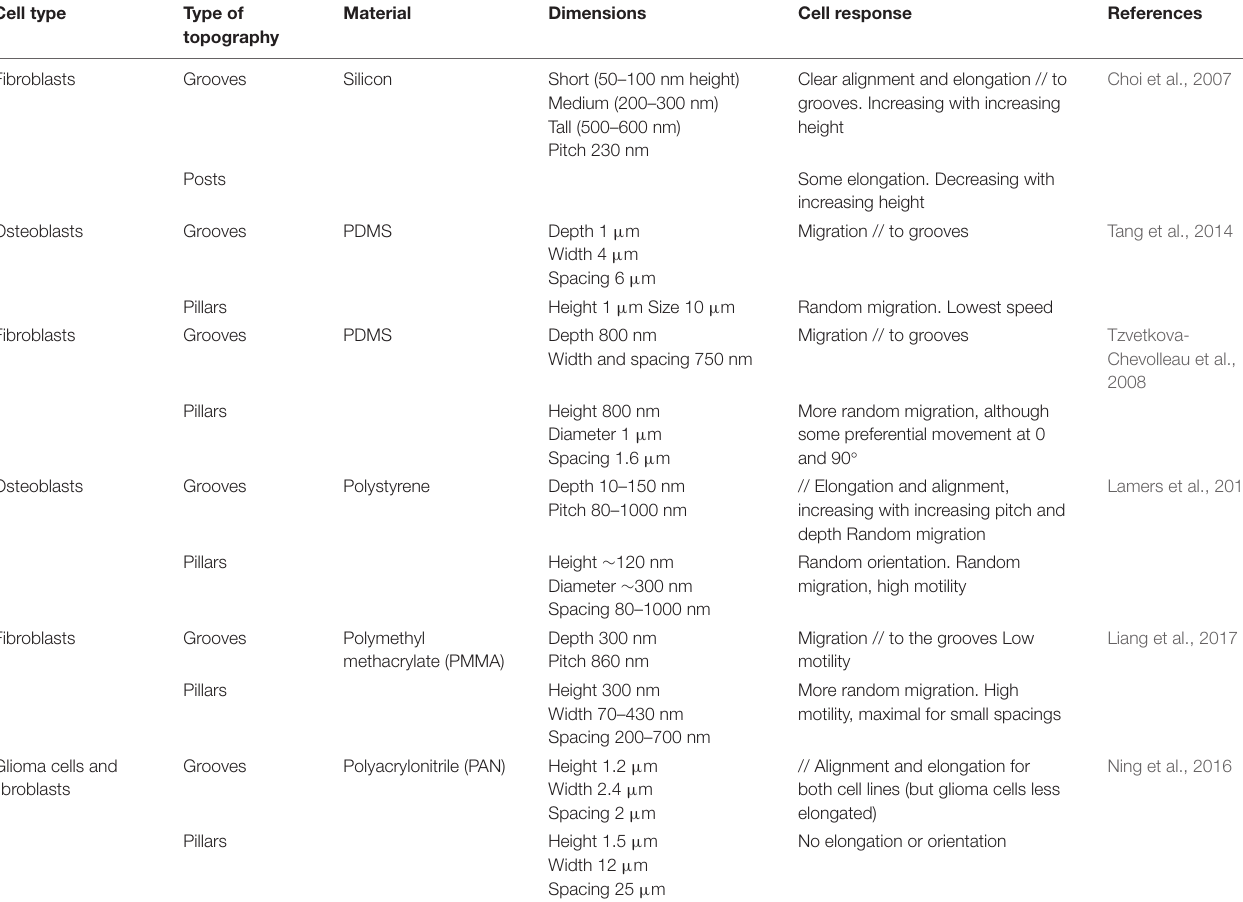
TABLE 2 | Cell responses to anisotropic versus isotropic